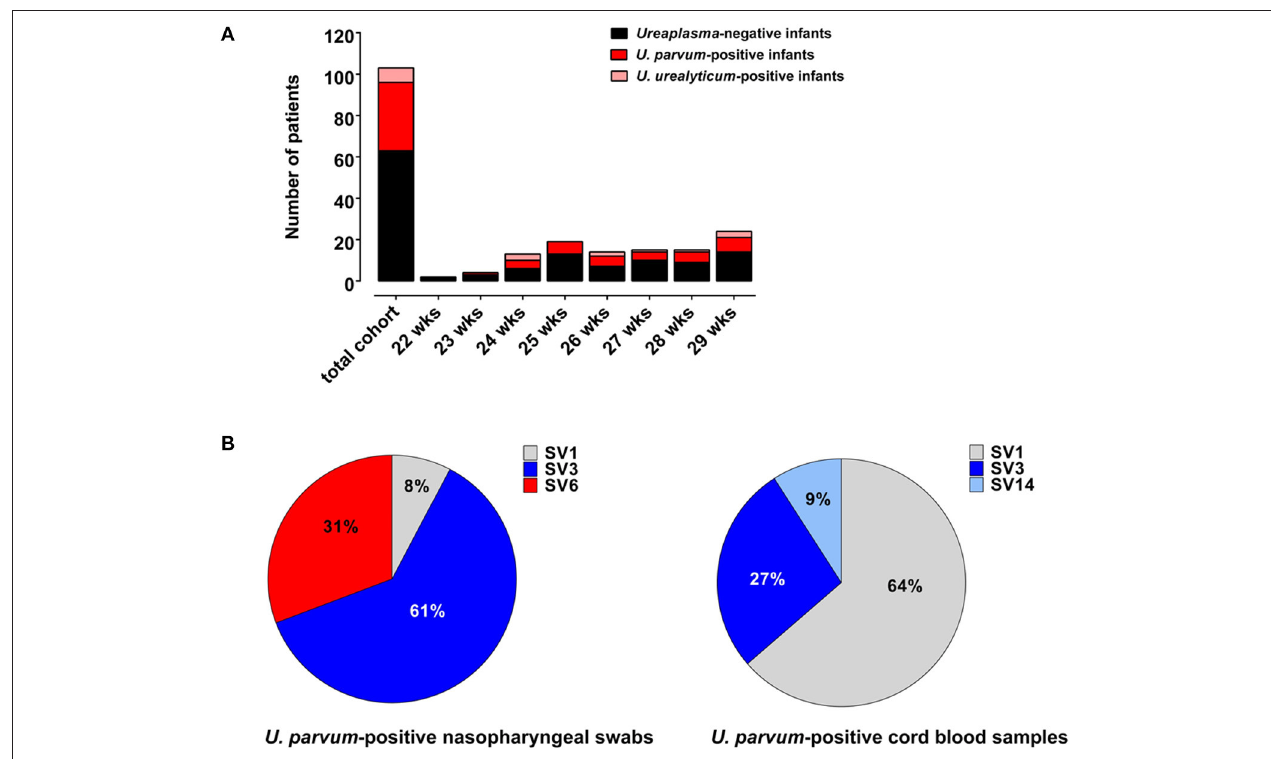
FIGURE 2 | (A) Numbers of Ureaplasma -negative infants as well as U. parvum -positive and U. urealyticum -positive infants given for each week of gestation (assessed as completed weeks). (B) Distribution of U. parvum serovars in Ureaplasma -positive swab and cord blood specimens.